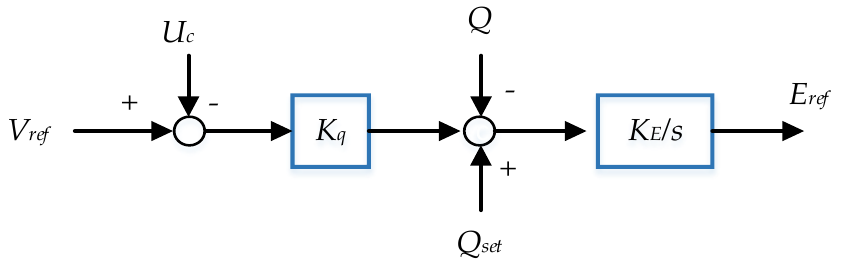
Figure 15. The control reactive power and voltage.